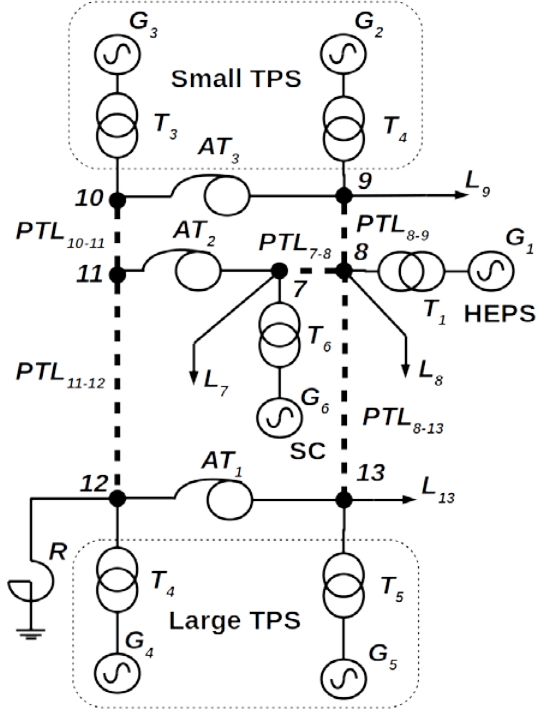
Fig. 1. One-line diagram